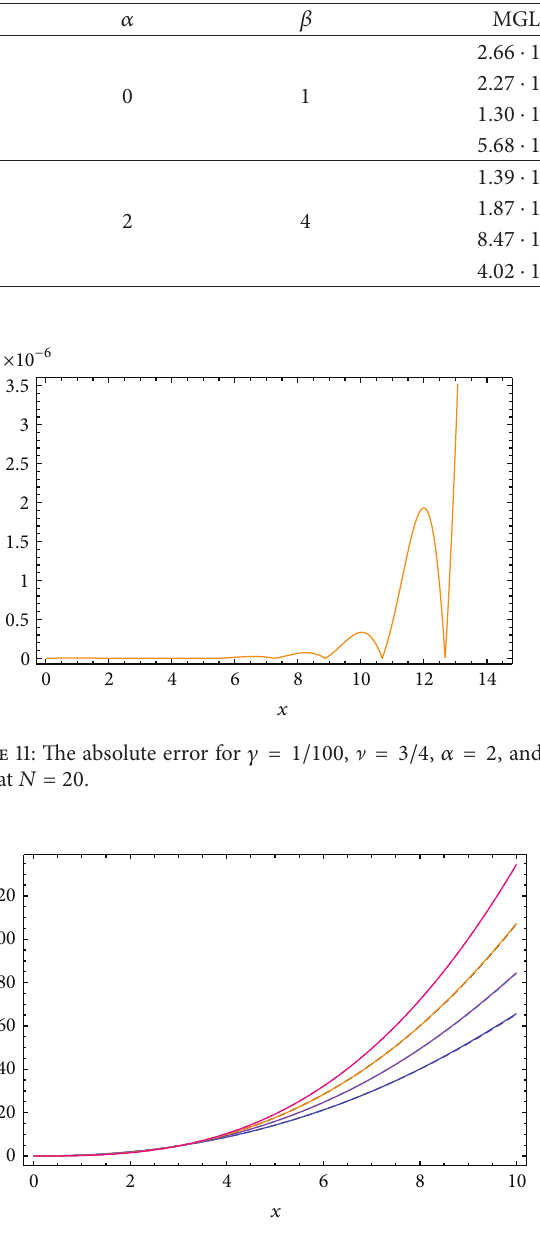
Comparison between the curves of exact solutions and the approximate solutions at 𝛼 = 0 and 𝛽 = 1 of proposed problem subject to 𝑢(0) = 𝑢 󸀠 (0) = 0 for the four different fractional orders ] = 1.2 , 1.4, 1.6, and 1.8 in case of 𝑁 = 12 and 𝑁 = 16 are shown in Figures 12 and 13, respectively.